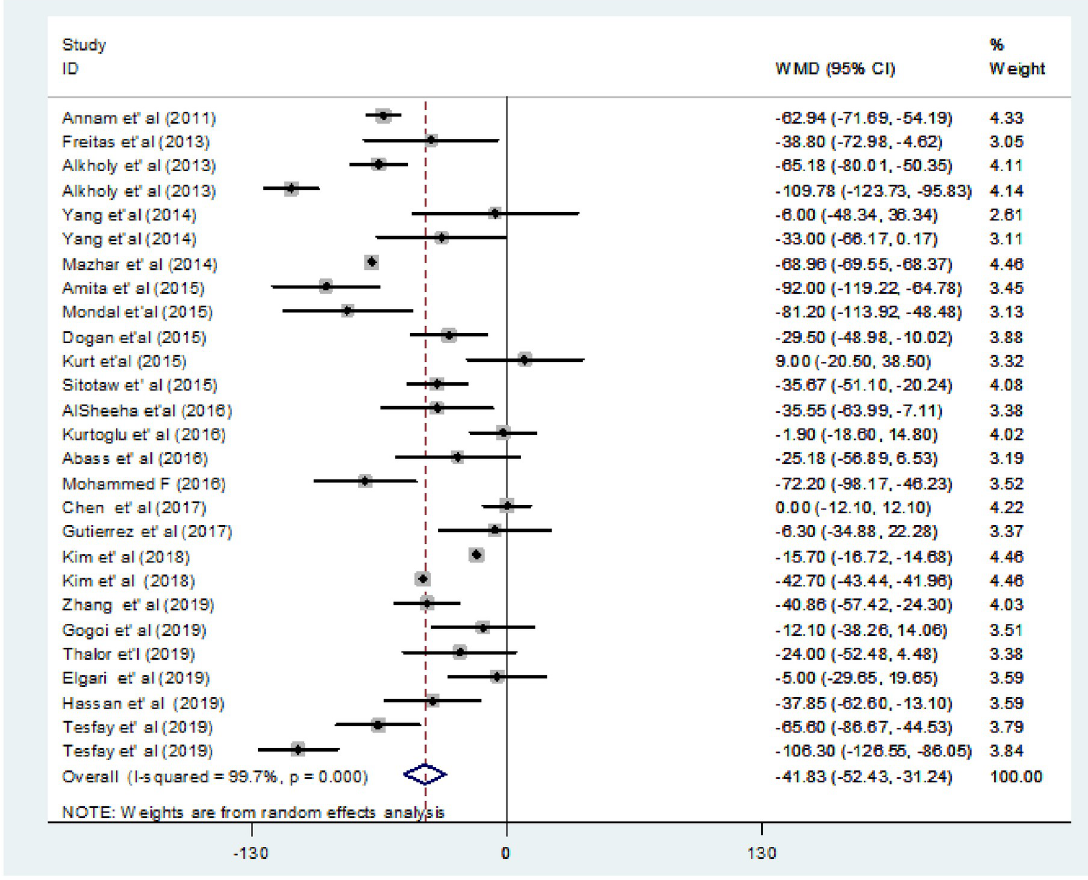
Fig 2. Forest plot of included studies for the pooled WMD estimate of PC between PE and NT groups.